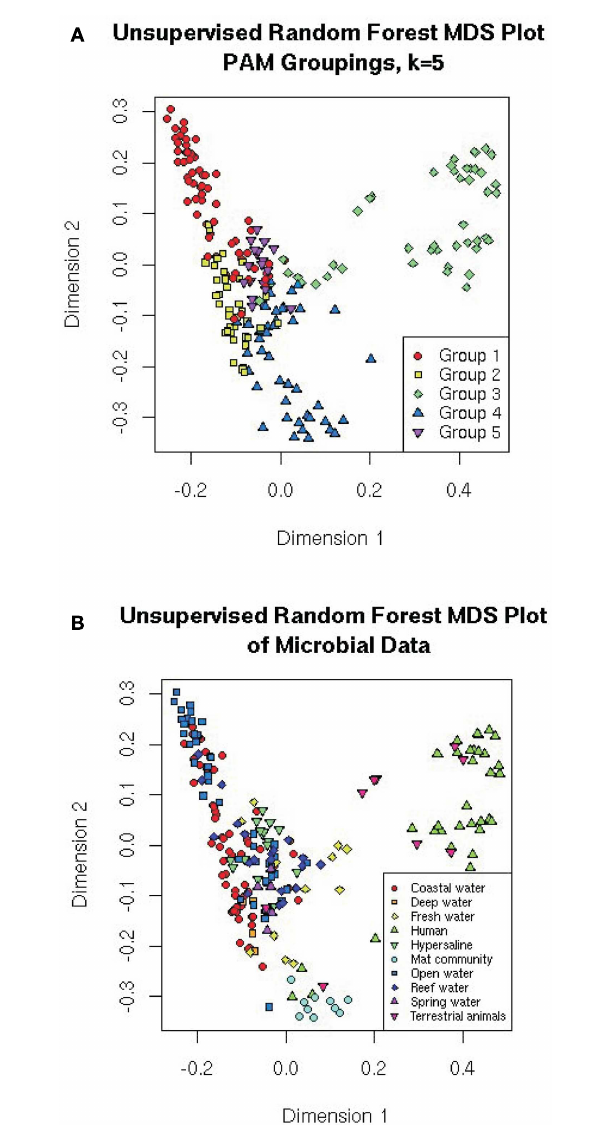
FIGURE 6 | Multiple dimensional scale plots of the distances calculated from the unsupervised random forest. The distances are the number of times the samples appear on the same leaf of the tree, and the MDS has scaled them so that they plot projects those distances into two dimensions. Colored by (A) the five PAM groupings suggested by the random forest (see text); or (B) the original environments the samples came from.